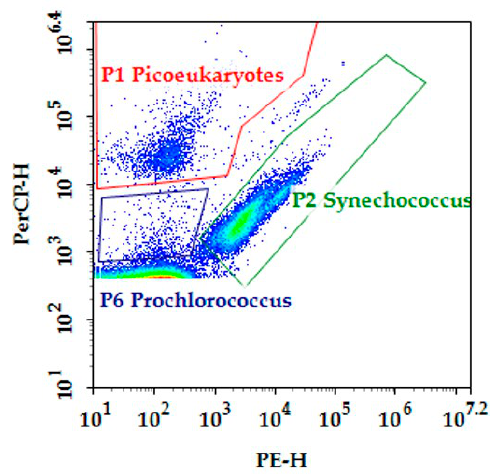
Figure 2. Flow-cytometric analysis of a picophytoplankton sample. The signatures of each picoplankton group were discriminated based on their orange and red fluorescence intensities. PerCP-H: red-fluorescence, PE-H: orange-fluorescence, P1: picoeukaryote count, P2: Synechococcus count, P6: Prochlorococcus